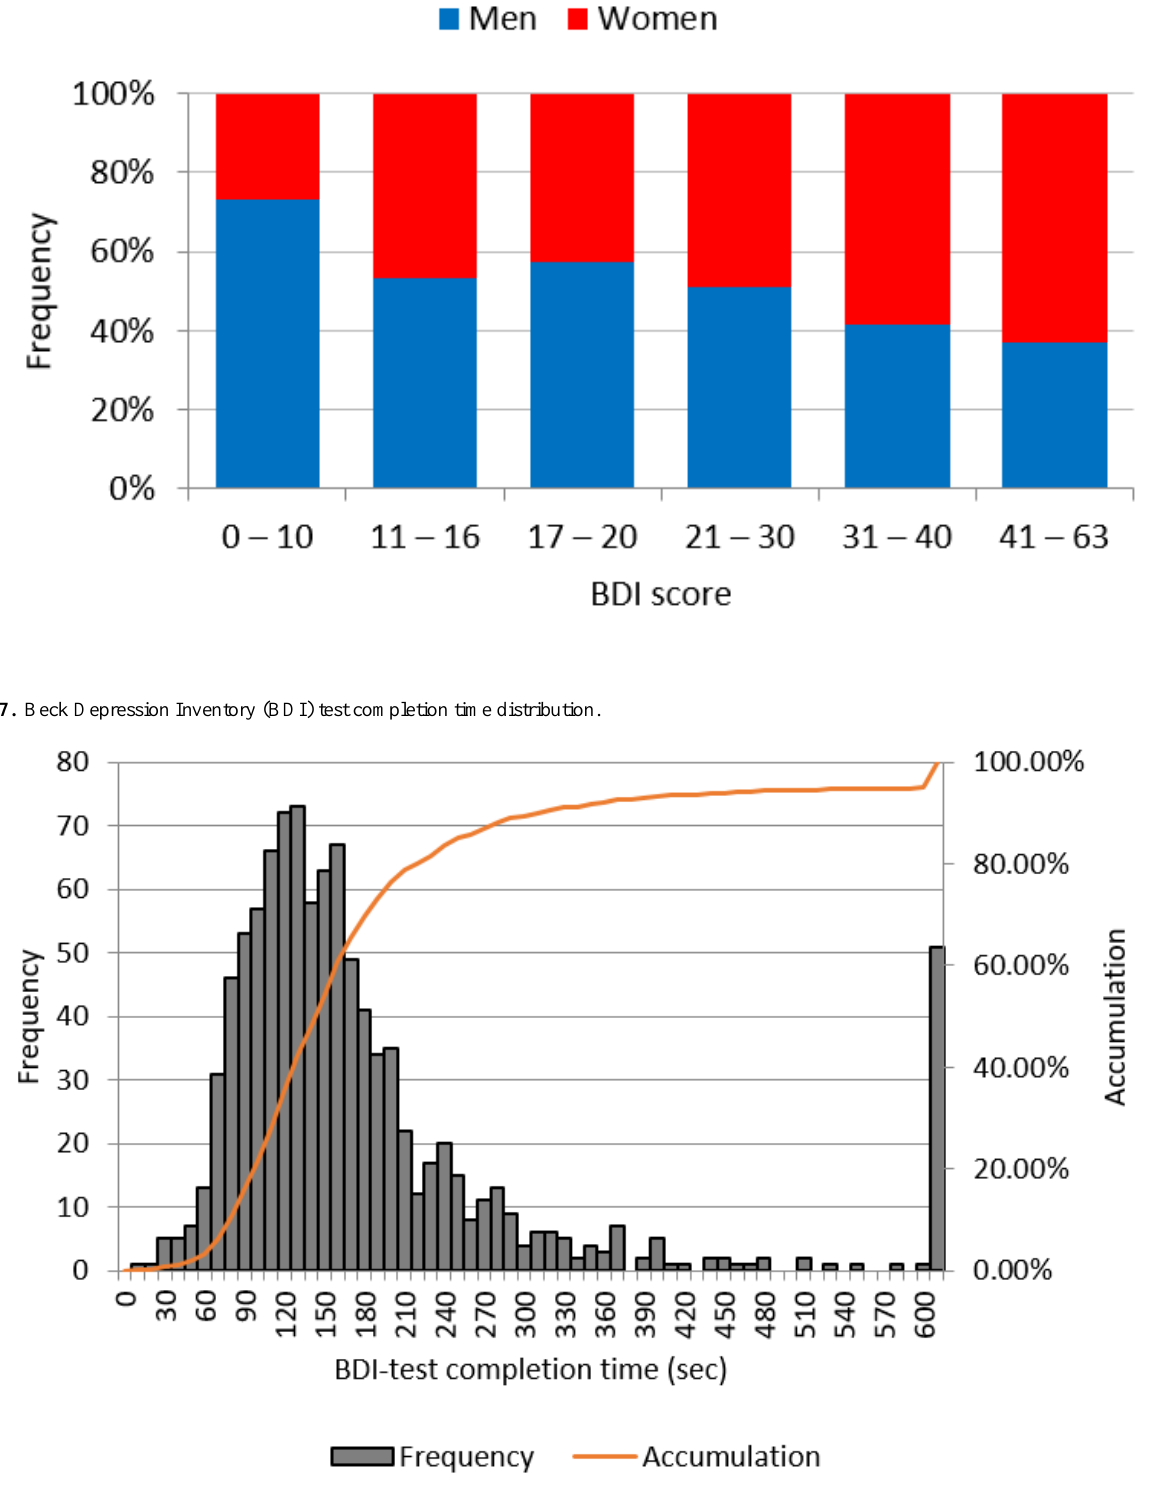
Figure 6. Beck Depression Inventory (BDI) score distribution by sex.